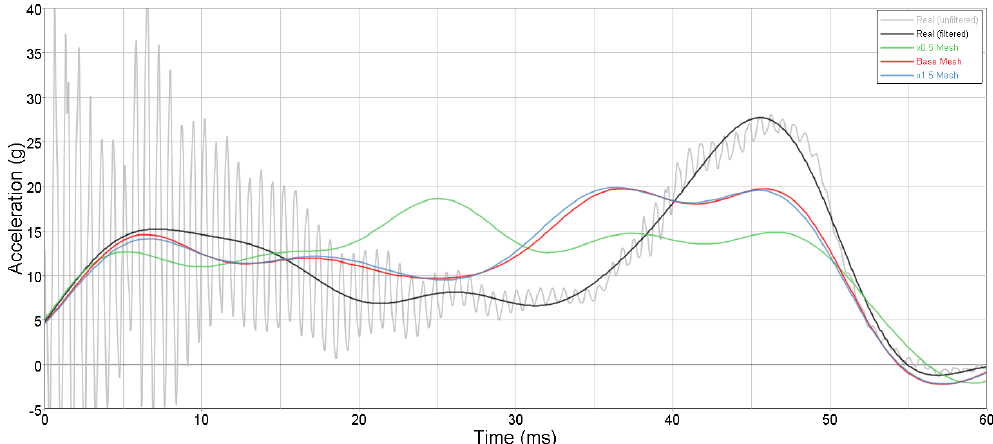
Figure 7. Acceleration of the impact block in the real test unfiltered (grey) and after filtering (black). The simulation cases for different meshes are represented in green (coarse mesh), red (the reference mesh) and blue (the finer mesh). We can see that the reference mesh is converged (minimal differences appear when the mesh is refined further).